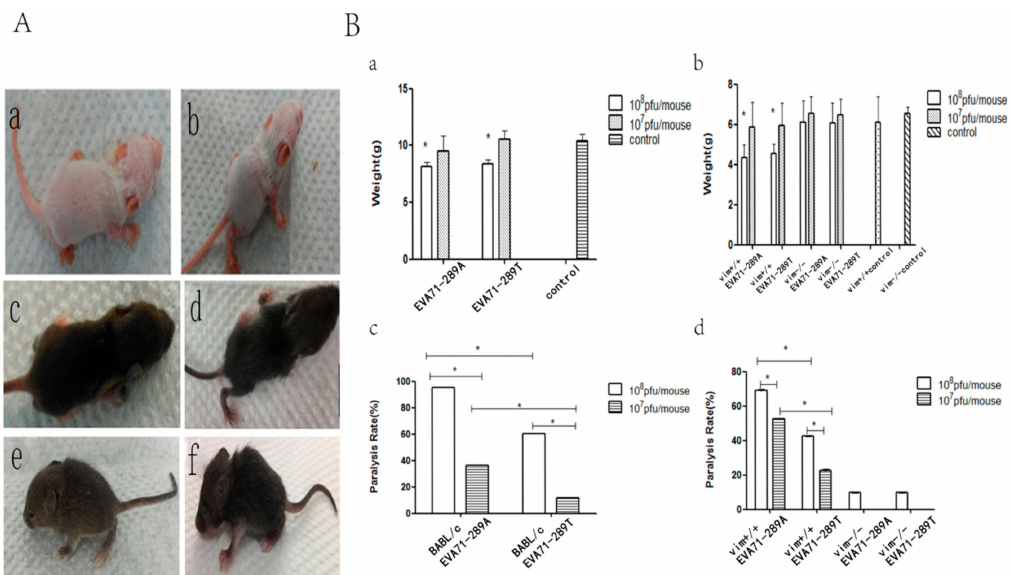
Figure 4. Incidence after EV-A71-289A and EV-A71-289T infections in BALB / c mice and SV129 mice. Onset of infection including weakness, reduced activity, tremor, hunchback, ru ffl ed fur, and hind limb paralysis was observed 3 to 7 d after EV-A71-289A infection and 4 to 8 d after EV-A71-289T infection. ( a , c : Control BALB / c and SV129 mice, b , d , e , f : Mice infected by EV-A71). ( A ) Change in body weight and morbidity ( a , b : The change in weight in BALB / c and SV129 mice, c , d : Morbidity of BALB / c and SV129 mice)( B ). Asterisks indicate significant di ff erences ( p < 0.05 by t -test).